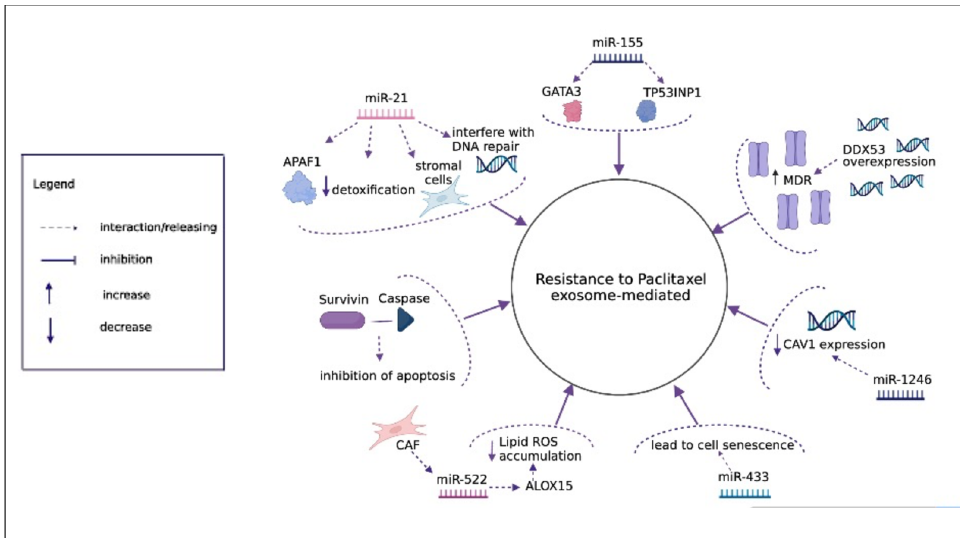
Figure 3. Exosome-mediated mechanisms of resistance to paclitaxel. The overexpression of DDX53 secreted by exosomes enhances the expression of MDR1. Exososomal survivin inhibits apoptosis interacting with downstream caspases. Exosomal miR-433 interferes with different pathways leading to cell senescence. Exosomal miR-21 confers resistance in different ways: targeting APAF1, being involved in detoxification and in DNA repair mechanisms. Exosomal miR-155 confers chemoresistance targeting GATA3 and TP53INP1. Exosomal miR-522 secreted from CAF suppresses ALOX15 that blocks lipid ROS accumulation. Exosomal miR-1246 mediate chemoresistance transmission targeting Cav1 gene.